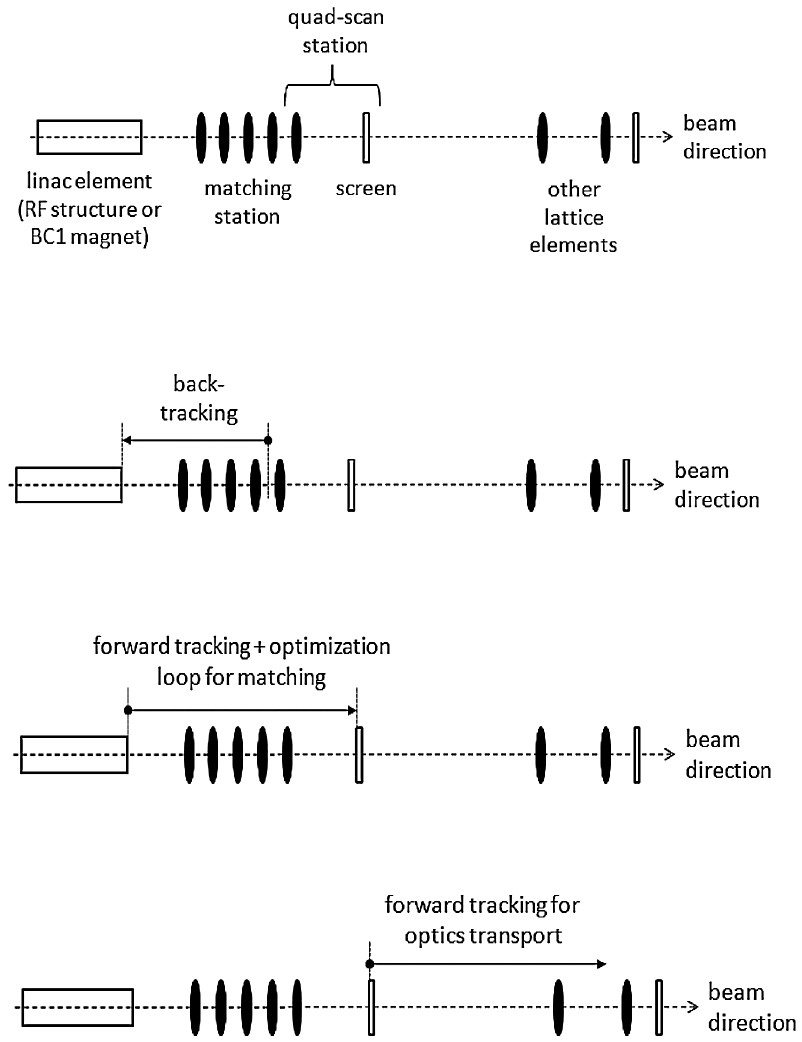
FIG. 2. Illustration of the optics matching loop. From top to bottom: (i) the beam Twiss parameters are measured with the quadrupole scan technique at the entrance of the last quadrupole magnet of the matching station; (ii) the present machine configuration is read by ELEGANT and the measured Twiss parameters are back-tracked to a point upstream of the matching station; (iii) starting from the present machine configuration, ELEGANT starts optimizing the quadrupole strengths to match the beam Twiss parameters to the design values; (iv) once the matching has been performed, the beam is transported through the downstream